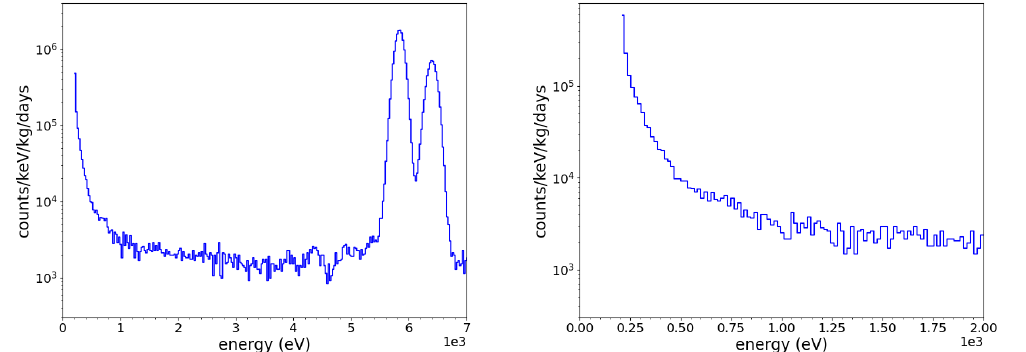
Figure 6: (left) MINER: The spectrum obtained from a 4mm thick sapphire detec- tor with the 55 calibration lines, (right) The low energy excess. These events were obtained using a triggerless DAQ followed by software trigger for